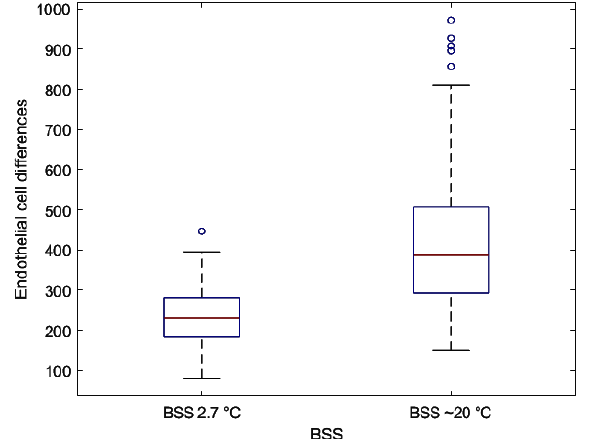
Figure 3. The distribution of endothelial cell differences between pre- and post- treatment with BSS at 2.7 °C and at ~20 °C.